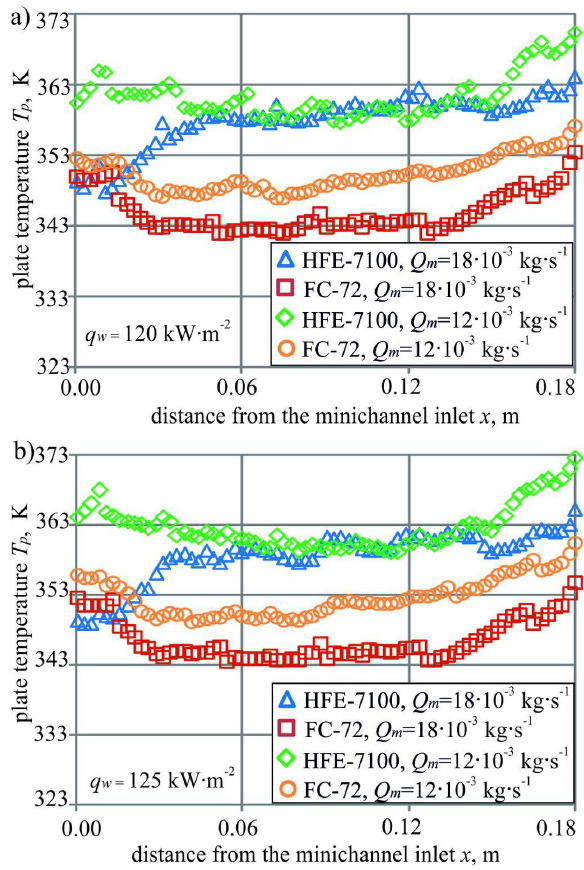
Fig. 5. Plate temperature vs. distance from the minichannel length obtained for the saturated boiling region, experimental parameters shown in Table